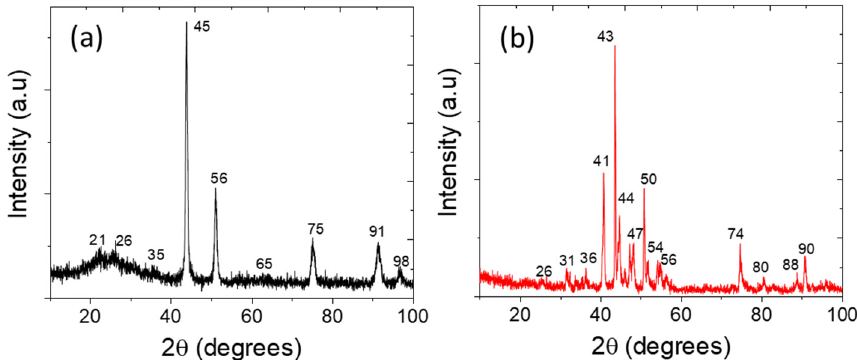
Figure 3. ( a ) XRD patters for NiFeCo/NC and ( b )